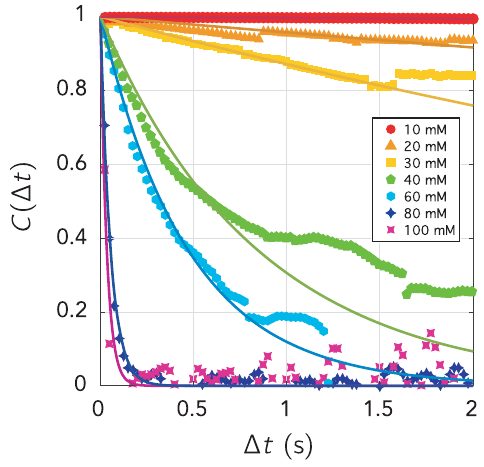
FIG. 5. Normalized autocorrelation of the velocity for each concentration. Each dataset is computed from averaging the C ð Δ t Þ of experimental trajectories at a given concentration. Solid lines are fit with an exponential decay following Eq. (2).